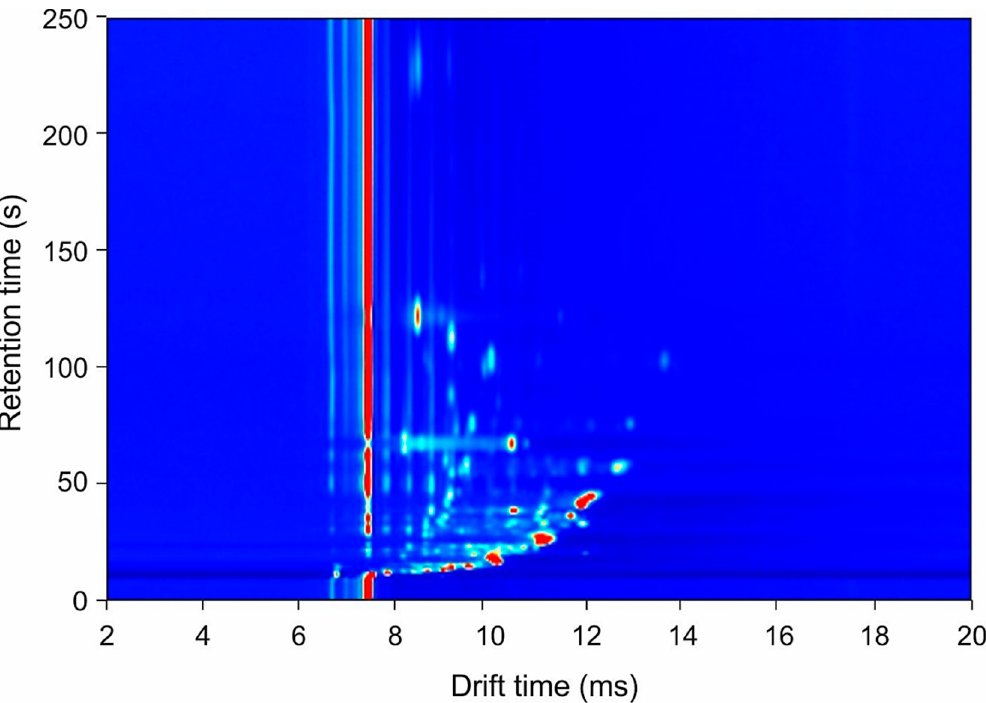
Outcomes obtained using support vector machine (SVM) analyses based on the 100 most discriminating features. Abbreviations: AUC, area under the curve; CI, confidence interval; PPV, positive predictive value; NPV, negative predictive value; CD, coeliac disease; RCD, refractory coeliac disease; HC, healthy controls.